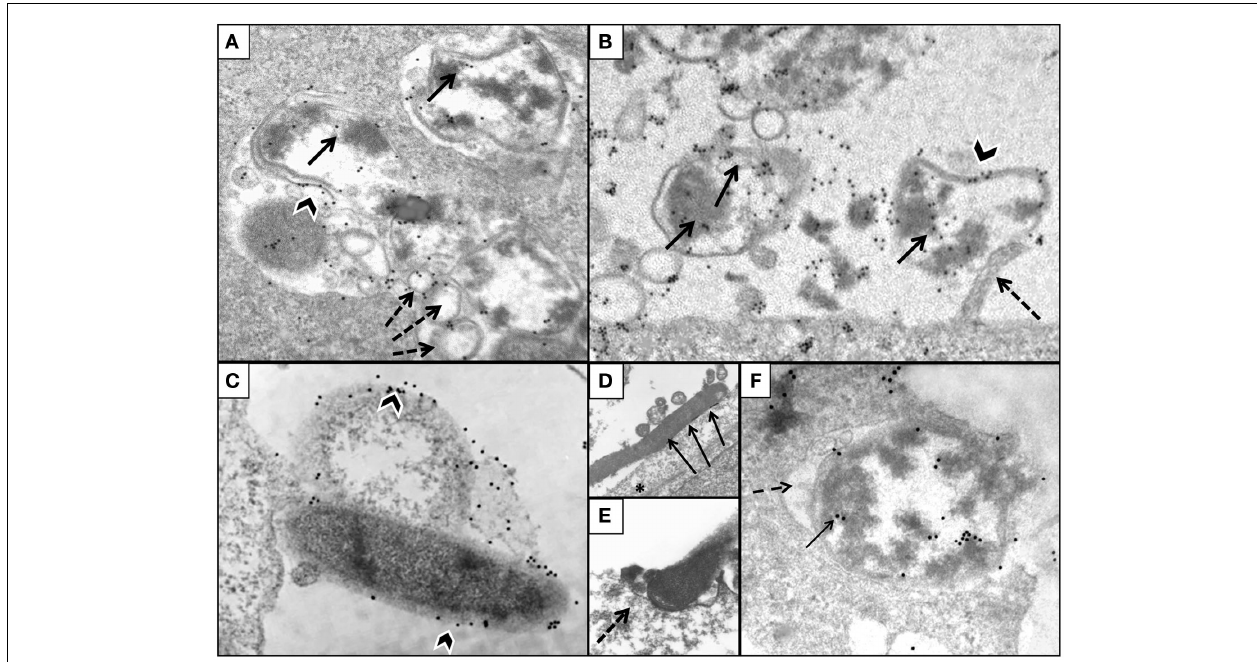
note multiple fusions between membranes of bacterium and AGS cell (arrows). (E) Higher magnification of “zipper-like” Δ nudA allele allele entry into AGS cell; note “cup formation” (dashed arrows) identifying H. pylori and AGS cell membranes fusing together during internalization. (F) Δ nudA allele almost completely englobed within invagination of AGS cell membrane; note that this fusion is accompanied by the presence of filamentous strands (fibrils), dense round spheres, vesicles, and amorphous deposits in the space between the membranes of the bacterium and AGS cell (dashed arrow). Immunogold-tagged bacterium (solid arrow) Original magnification (A–C) : 41,000 × ; (D) : 24,500 × ; (E) : 32,500 × ; (F) : 41,000 ×